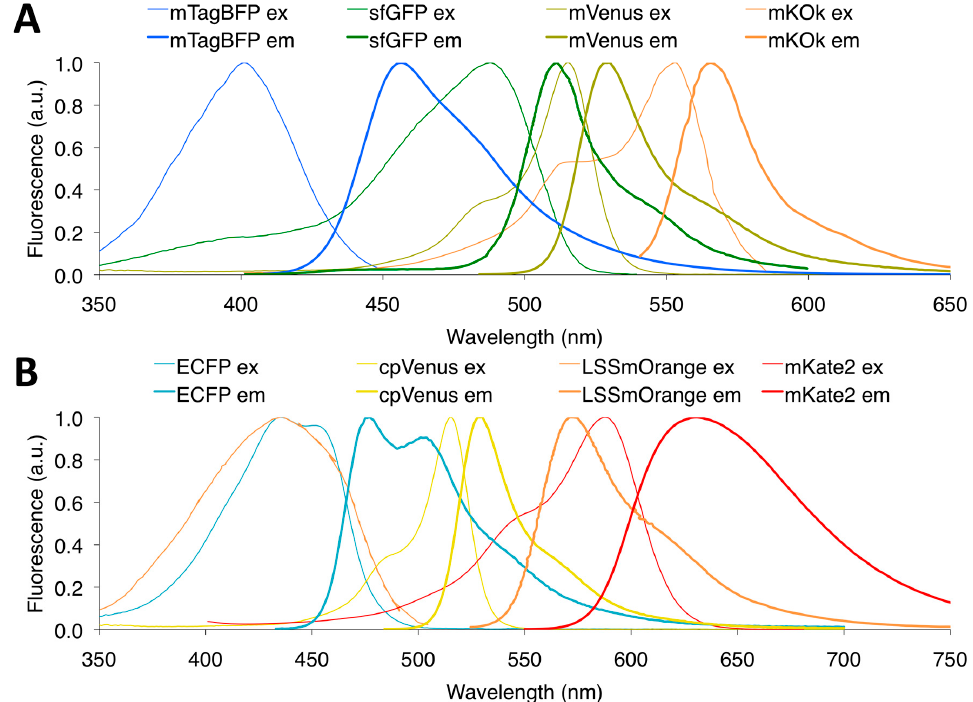
Figure 3. Normalized excitation (or absorbance) and emission spectra of FPs of representative four-color FRET pairs: ( A ) mTagRFP-sfGFP and mVenus-mKO κ pairs, two FRET pairs with two excitations; and ( B ) ECFP-cpVenus and LSSmOrange-mKate2 pairs, two FRET pairs with single excitation.